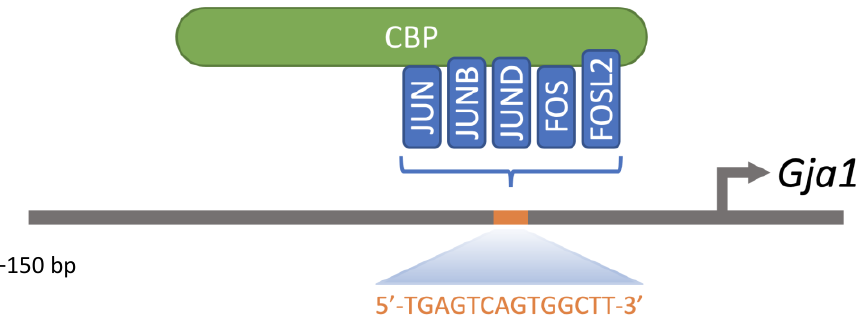
Figure 5. Overview of bZIP transcription factors recruited to the proximal region of the Gja1 promoter. JUN, JUNB, JUND, FOS and FOSL2 can participate in the formation of homo- or heterodimers to be recruited to the − 45 bp AP-1 DNA regulatory element.